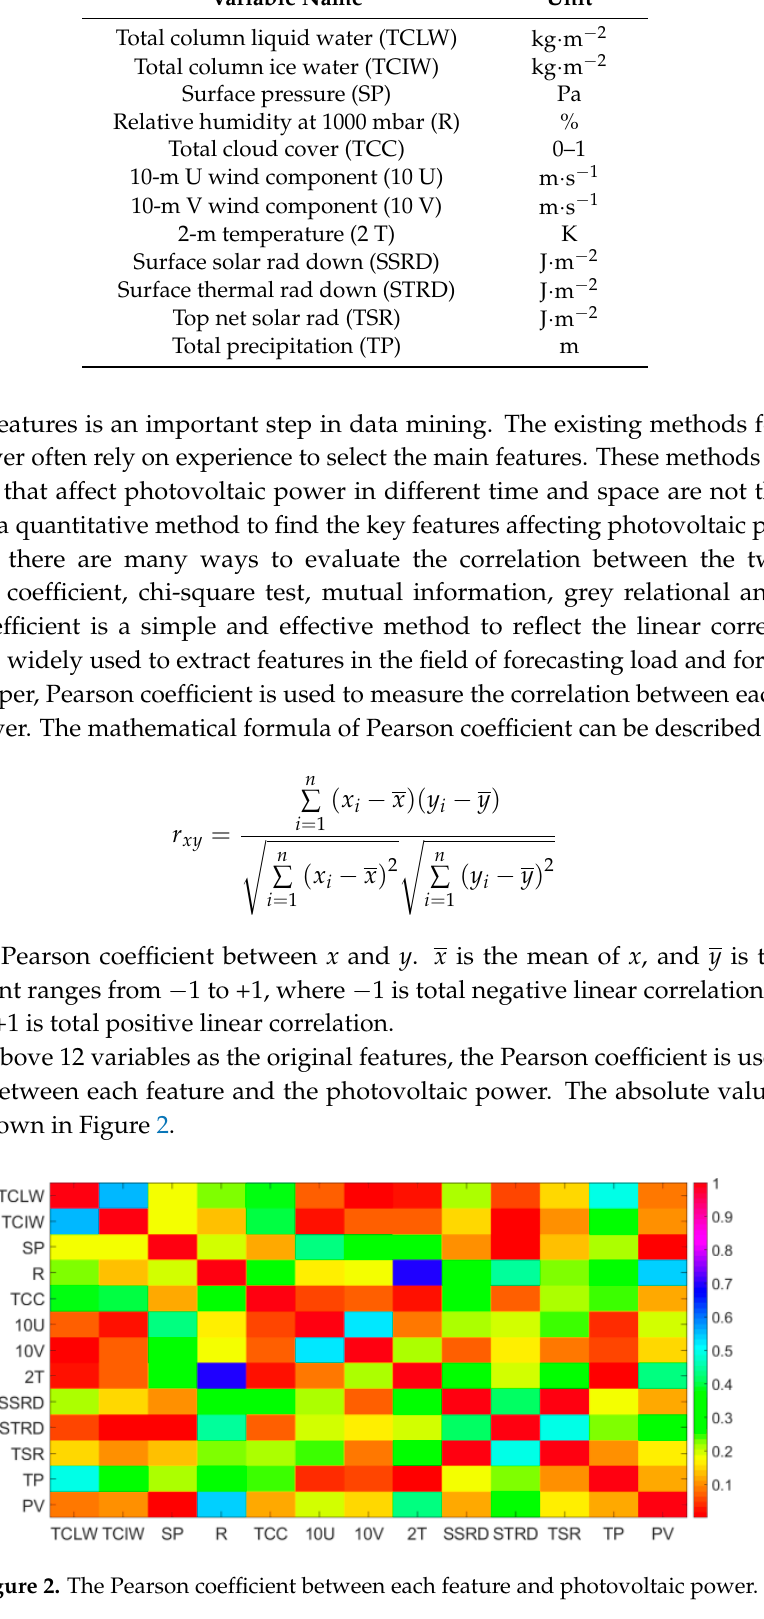
Table 1. Data variables and description.